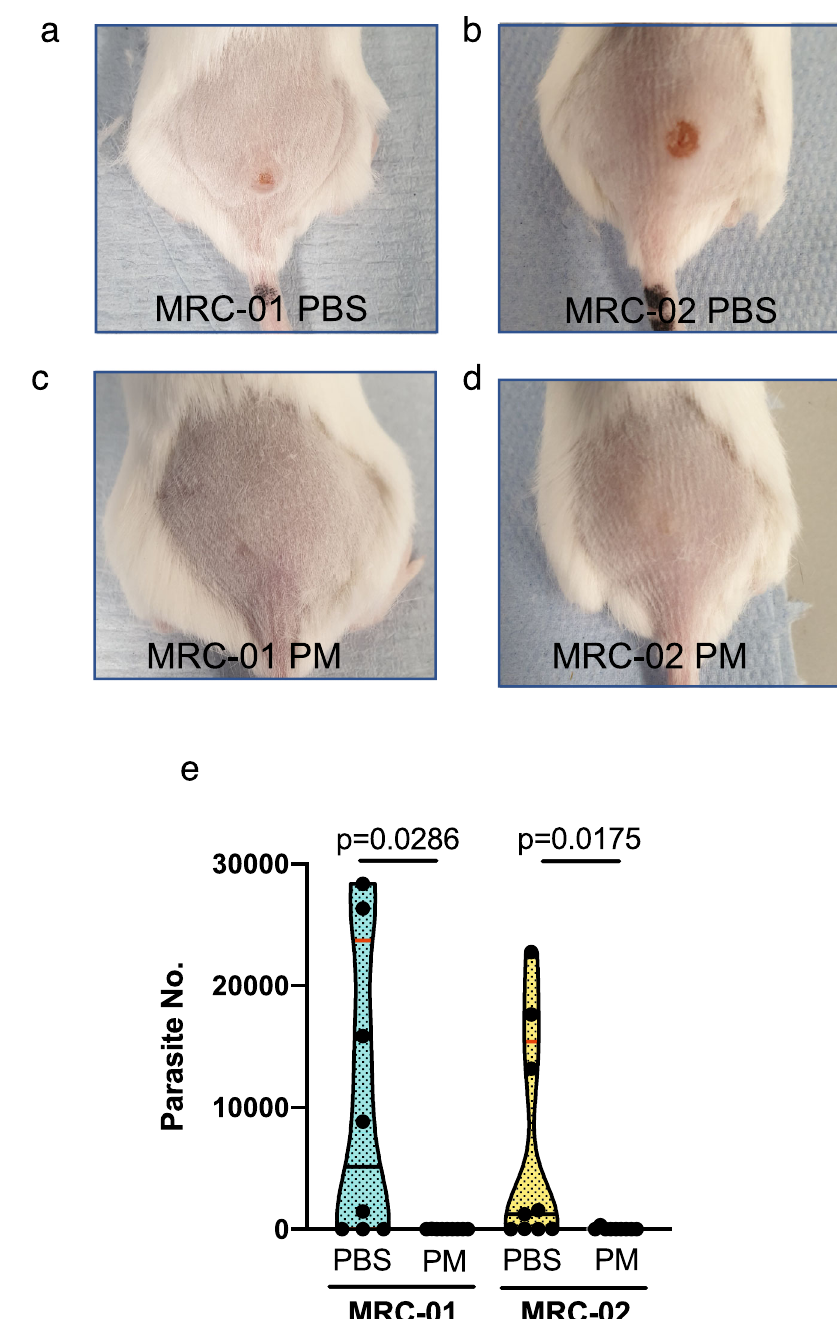
Fig. 4 Response of BALB/c mice infected with L. major MRC-01 and L. major MRC-02 to paromomycin treatment. Representative photographs of BALB/ c mice infected with L. major MRC-01 ( a , c ) and L. major MRC-02 ( b , d ) in absence of treatment ( a , b ) and at the end of 10 days paromomycin treatment ( c , d ). e Parasite loads in lesions of mice treated with paromomycin (PM) or vehicle (PBS), as determined by qPCR. Data are derived from two independent experiments with 9 mice per group for L. major MRC-02 with and without treatment and L. major MRC-01 with treatment and n = 8 mice for L. major MRC- 01 without treatment. Data are shown as violin plots truncated at the max/min values, with median (black line) and quartiles (red line) and individual data points indicated. Data comparing with and without treatment were analysed using a two-sided Mann – Whitney test, with p values as indicated. Source data are provided as a Source data fi infected with L. major MRC-02 (Supplementary Fig. 5). Thus, the limited expansion required to generate a GMP parasite bank does not negatively impact on parasite development in sand fl ies.